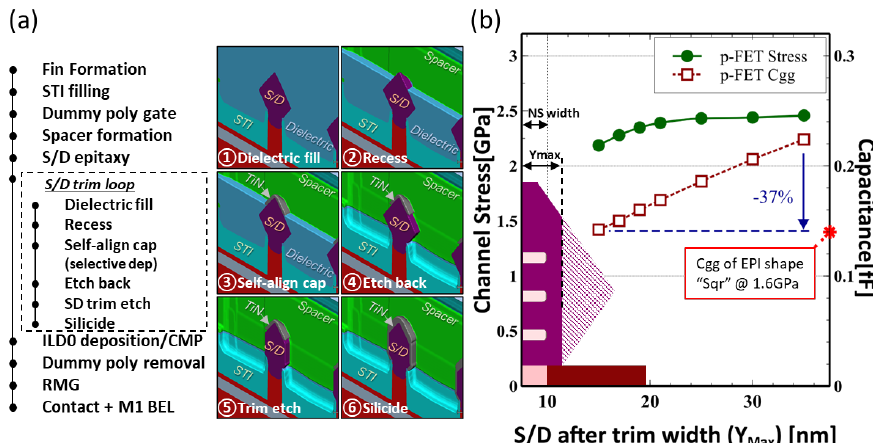
Figure 2. ( a ) Process details of self-aligned S/D trimming scheme and its relative position in the main flow with step by step process simulation animation; ( b ) average p-FET nanosheet channel stress and its corresponding capacitance as a function of its max width after